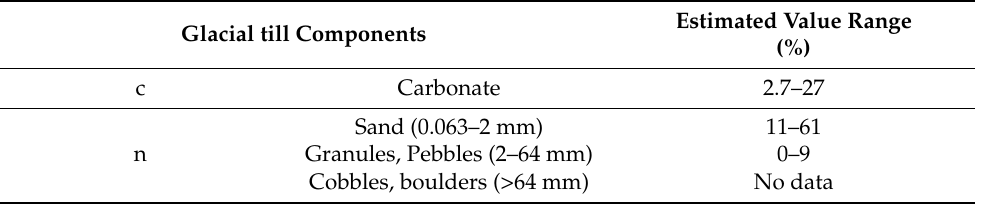
Table 2. Minima and maxima portions of c and n (0.063–64 mm) in the cliff-building glacial till derived from local studies *. The sediment is classified according to Wentworth [53].